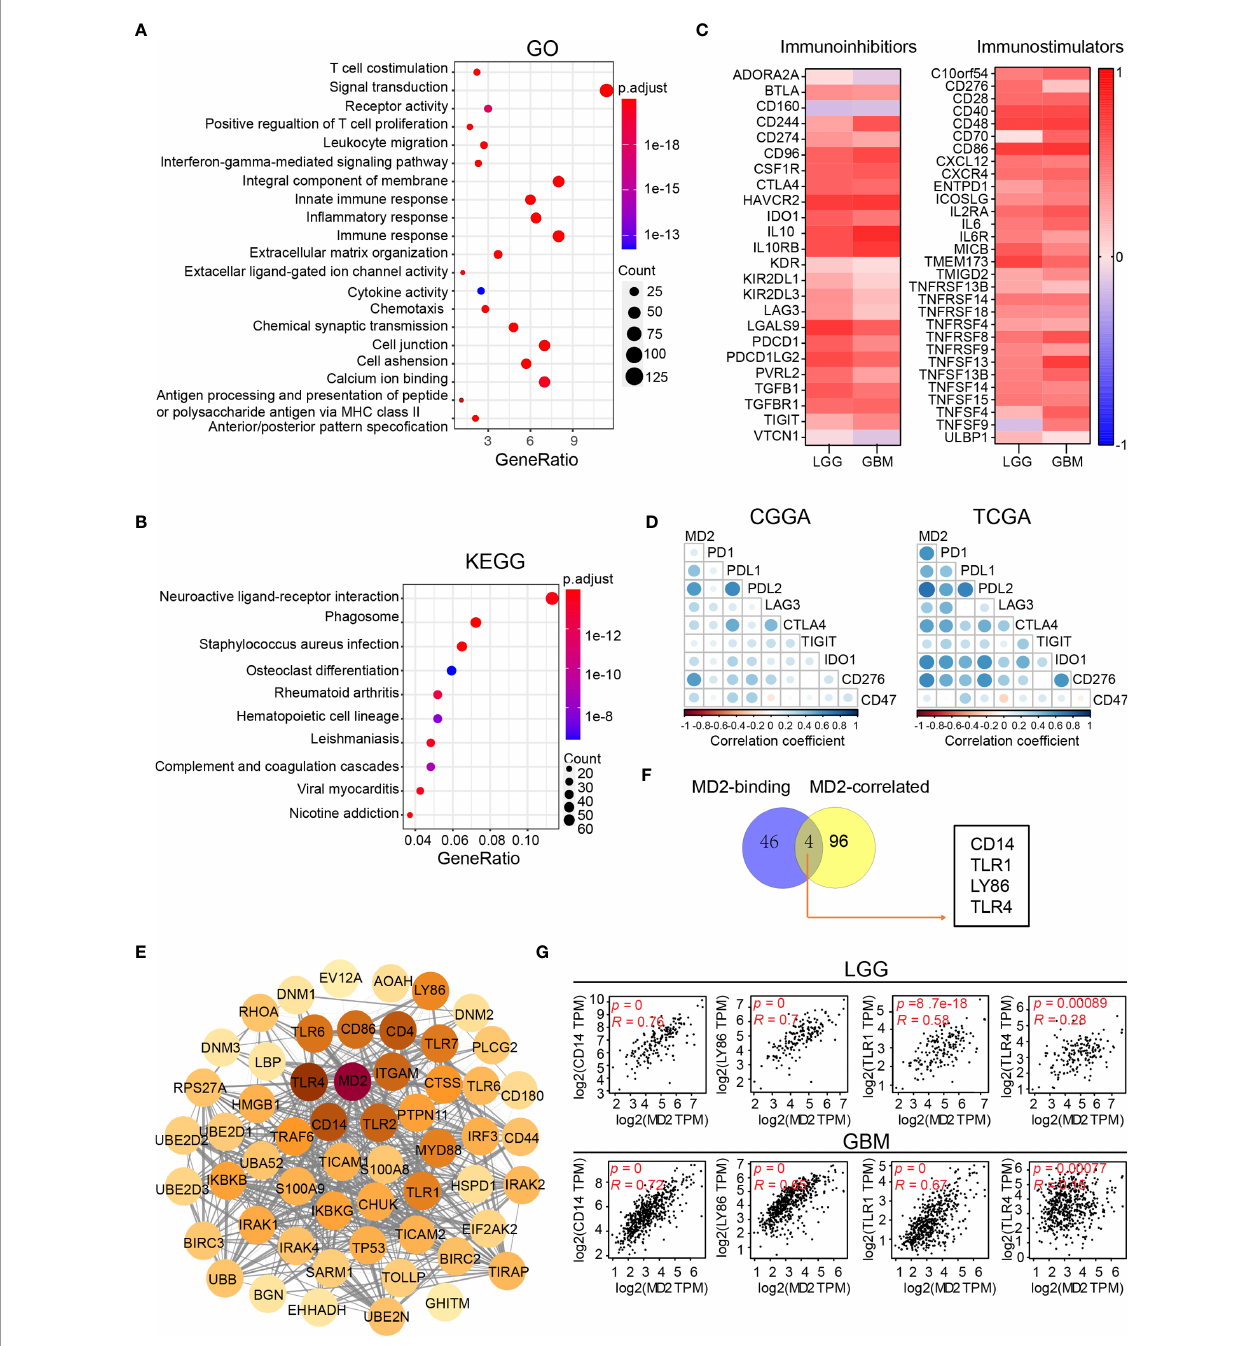
FIGURE 6 | Functional enrichment analysis of MD2. (A) Bubble plot of GO enrichment analysis of MD2-related signal pathway. (B) Bubble plot of KEGG enrichment analysis of MD2-related signal pathway. Node size indicates the number of contained in the corresponding GO/KEGG term, and the color of the node indicates the p -value. (C) The heatmap of correlation between the immunoinhibitors and MD2 expression in LGG and GBM (left); the heatmap of correlation between the immunostimulators and MD2 expression in LGG and GBM (right). (D) Correlation analysis of MD2 expression and nine immune-related checkpoints. (E) Protein- protein interaction network based on MD2-binding proteins and top 100 genes correlated with MD2 expression. (F) Interactive Venn diagram to analyze the overlapping genes between MD2-binding proteins and top 100 genes correlated with MD2 expression. (G) The correlation between the expression of MD2 and CD14, LY86, TRL1 and TRL4 in LGG and